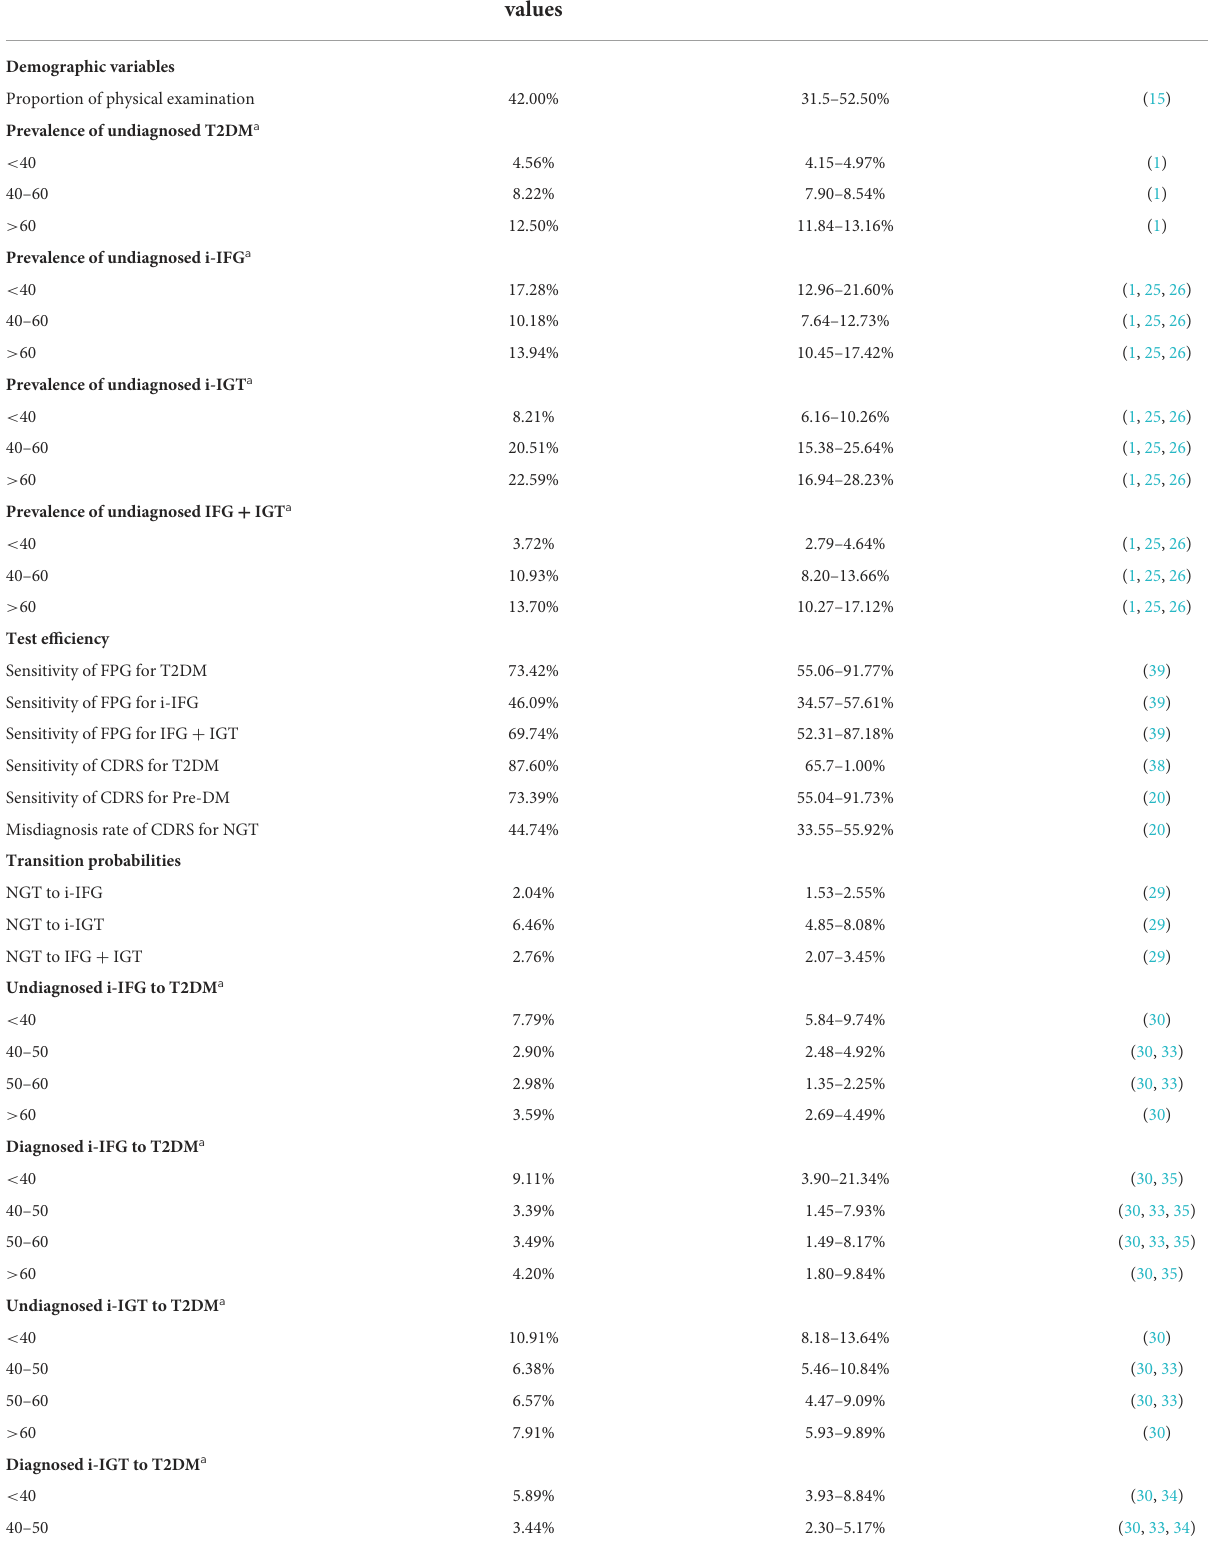
TABLE 1 Baseline values of input parameters used in